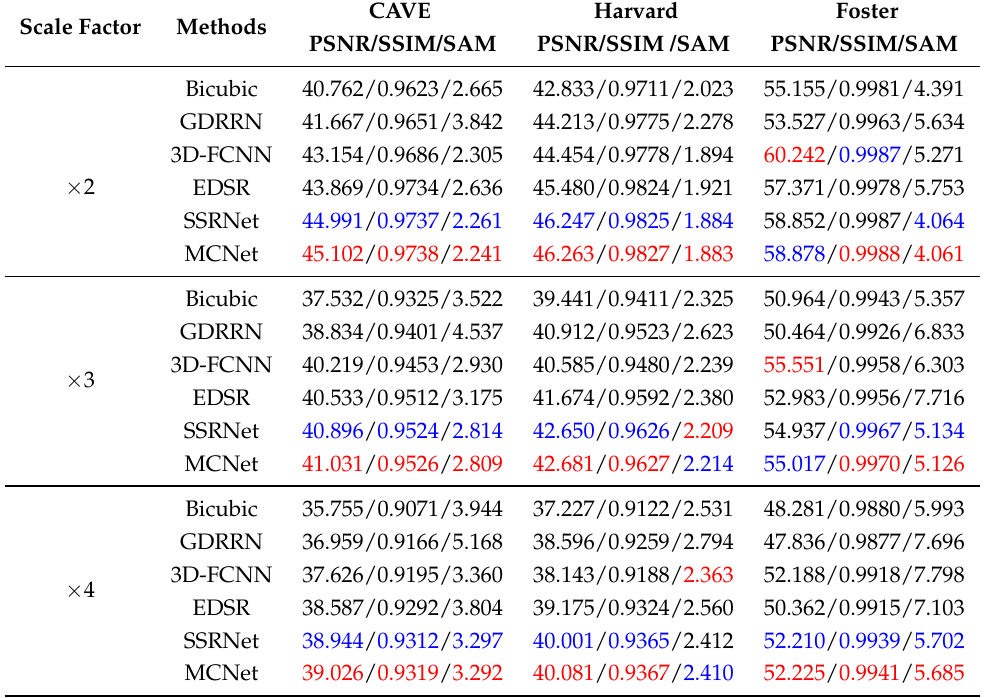
Table 3. Quantitative evaluation of state-of-the-art SR algorithms by average PSNR/SSIM/SAM for different scale factors. The red and blue indicate the best and second performance,